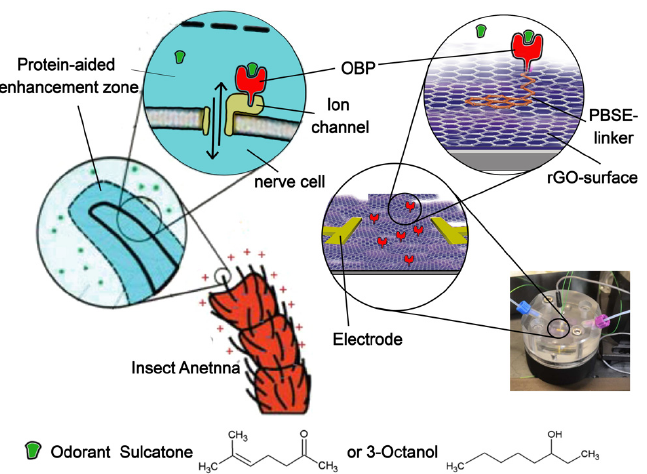
Figure 1. Nerve cell receptor in the insect’s antenna, mimicked by our synthetic receptor. Left side: nerve cells in the insect’s sensilium are equipped with the ion-channel receptor TcOr1, which binds OBPs (which, in turn, bind odorants) and responds with ion signaling [22]. TcOr1 faces into a liquid lymphatic solution that constitutes a protein-aided enhancement (or enrichment) zone [11,12]. Right side: synthetic receptor. Instead of a nerve cell membrane containing ion channels, the signal is generated by a highly surface charge-sensitive graphene semiconductor surface. OBPs remain communicatively linked to the graphene, which is sustained by a Si/SiO substrate. In both cases, the response is read out electrically, with electrodes placed at the antenna (for electroantennograms) or on the graphene surface (for rGO-FET measurements). The structures of both odorants are depicted at the